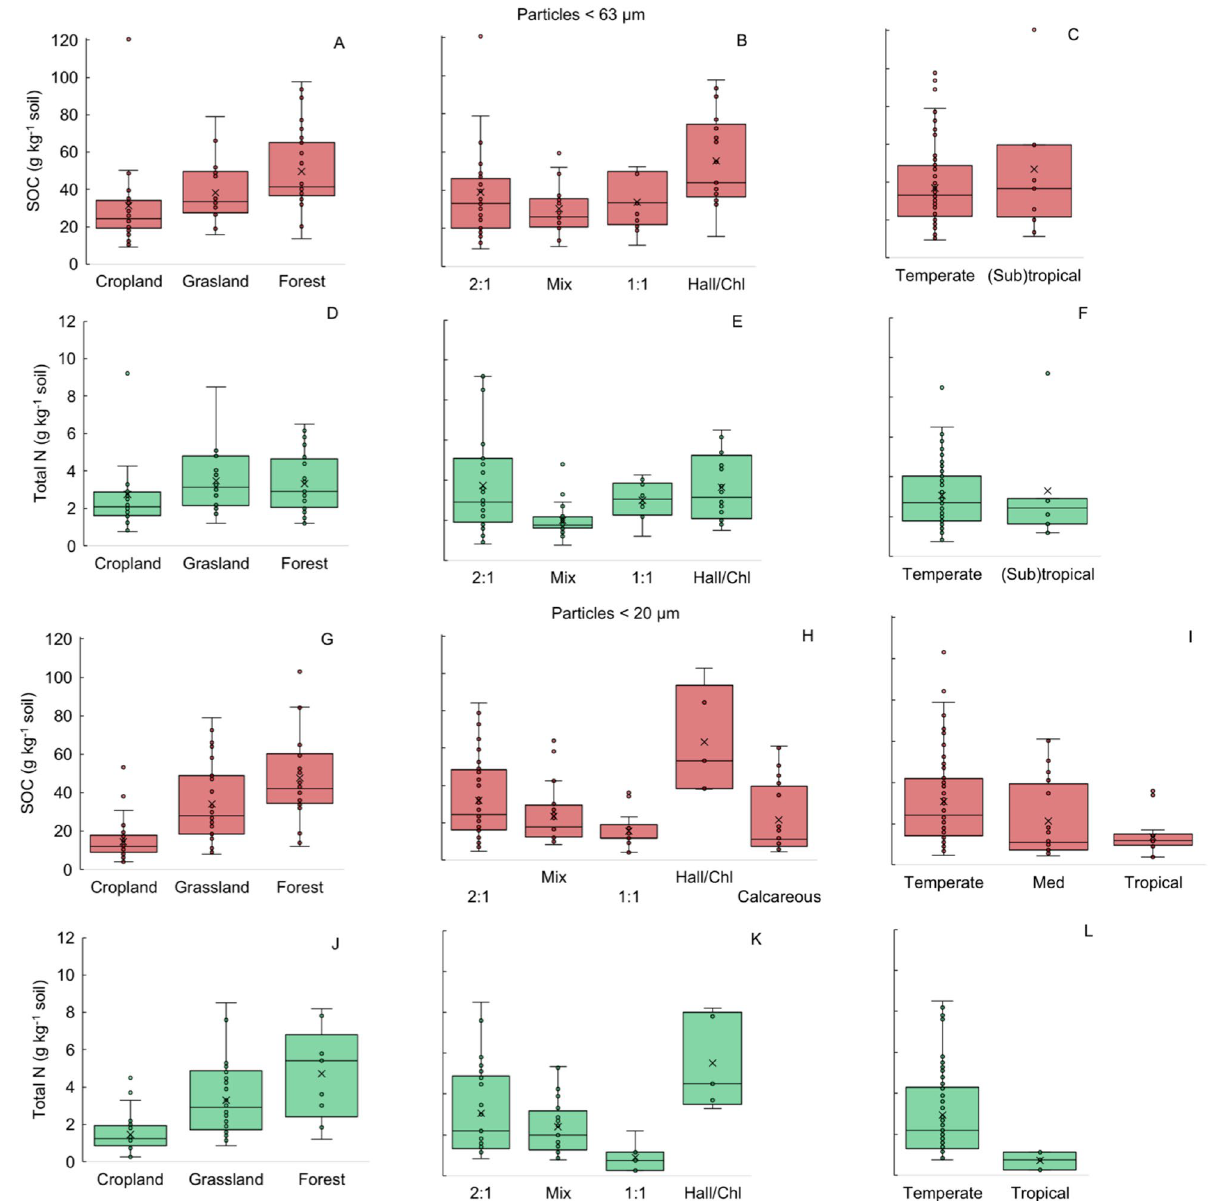
Figure 2. Box-and-whisker plots of soil organic carbon (SOC) distribution for land use, clay mineralogy and climate. The median is the black line and the x the mean of